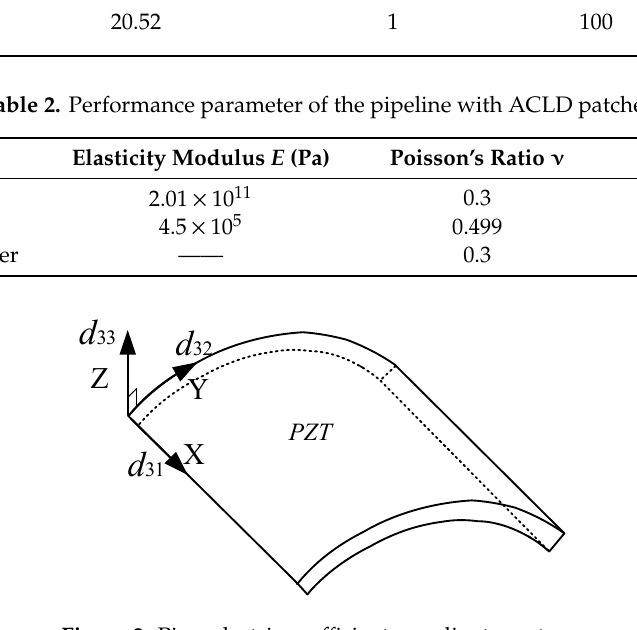
Figure 3. Piezoelectric coefficient coordinate system. Table 1. Geometric parameters of the pipeline with ACLD patches. Table 3. Performance parameter of the piezoelectric confinement